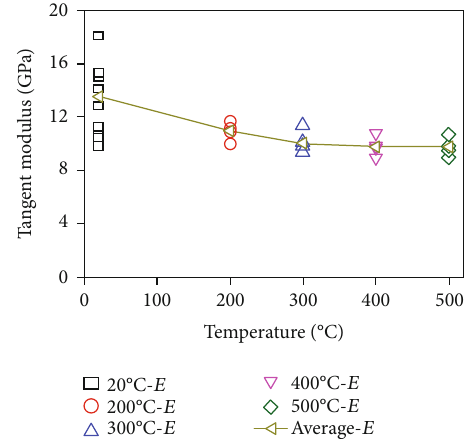
Figure 6: E ff ect of temperature on the tangent modulus of granite